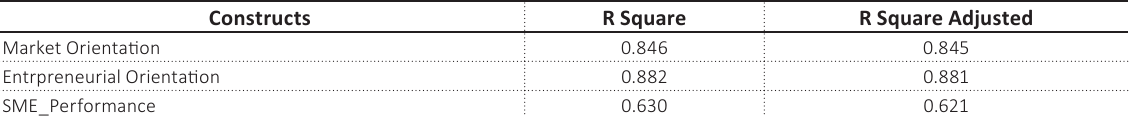
Table 7. Relationships of the first order constructs with their second-order constructs Second-order